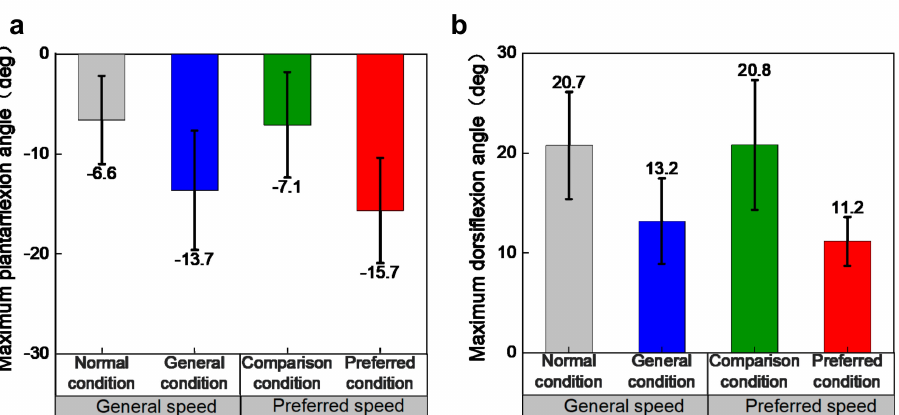
Figure 9. Ankle joint angles under different conditions; ( a ) mean (bars) and standard deviation (whiskers) of maximum plantarflexion angles under the normal condition (light grey bars), general condition (blue bars), preferred condition (red bars) and comparison condition (green bars); ( b ) mean (bars) and standard deviation (whiskers) of maximum dorsiflexion angles under the normal condition (light grey bars), general condition (blue bars), preferred condition (red bars) and comparison condition (green